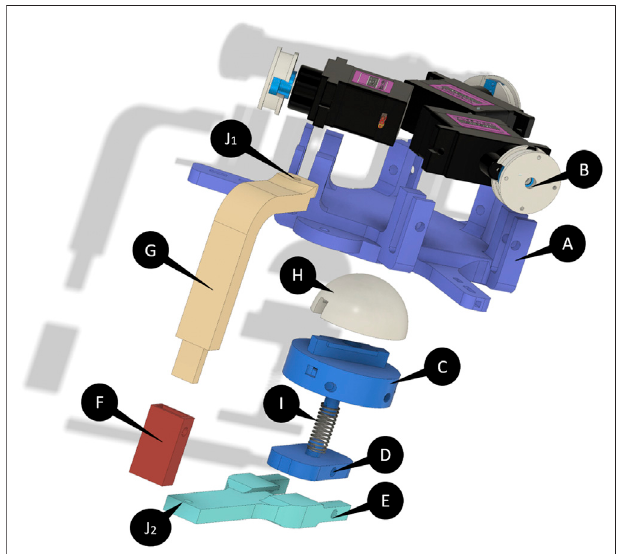
FIGURE 4 | Exploded CAD view of the device. The end-effector of the device is composed of the components indicated with (C,I,D) . (H) indicates the end-effector ’ s module while the “ Y-shaped ” platform is indicated with (A) and thepulleysareindicatedwith (B) . (E – G) aretheelementsthatrealize thelinkbetweenthetwoplatforms. (J 1 ) and (J 2 ) arethetwojointsthatallowed to rotate the